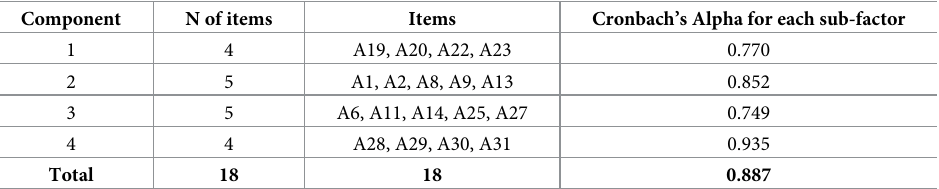
Table 9. Internal reliability for the construct.